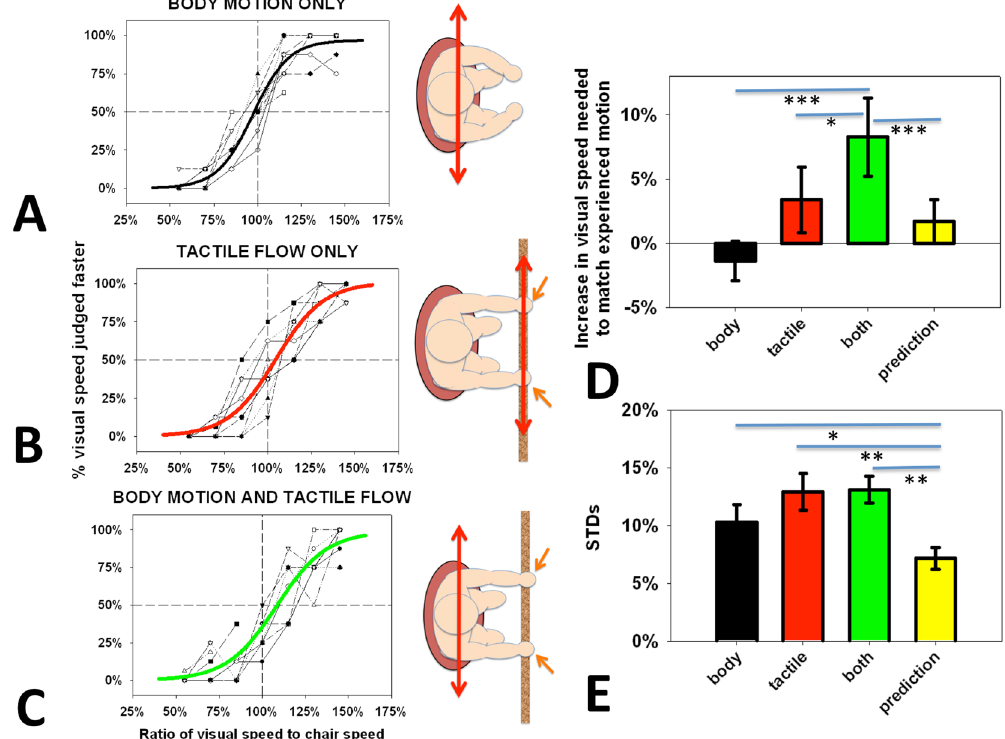
Figure 2. Speed judgments of the peak velocity of body, tactile or combined motion plotted as a function of the ratio of the visual speed to swing’s speed. Data are shown for each participant with a best-fit sigmoid fitted to the means for body motion only ( A ), tactile flow only ( B ), and both ( C ). Sigmoids were fit to each participant’s data and the mean increase in the points of subjective equality (PSE) at which the visual movement matched the experienced motion ( D ) and standard deviations ( E ) are plotted with standard errors and compared to the predictions of the optimum integration model (yellow bars). Horizontal lines with asterisks indicate statistically